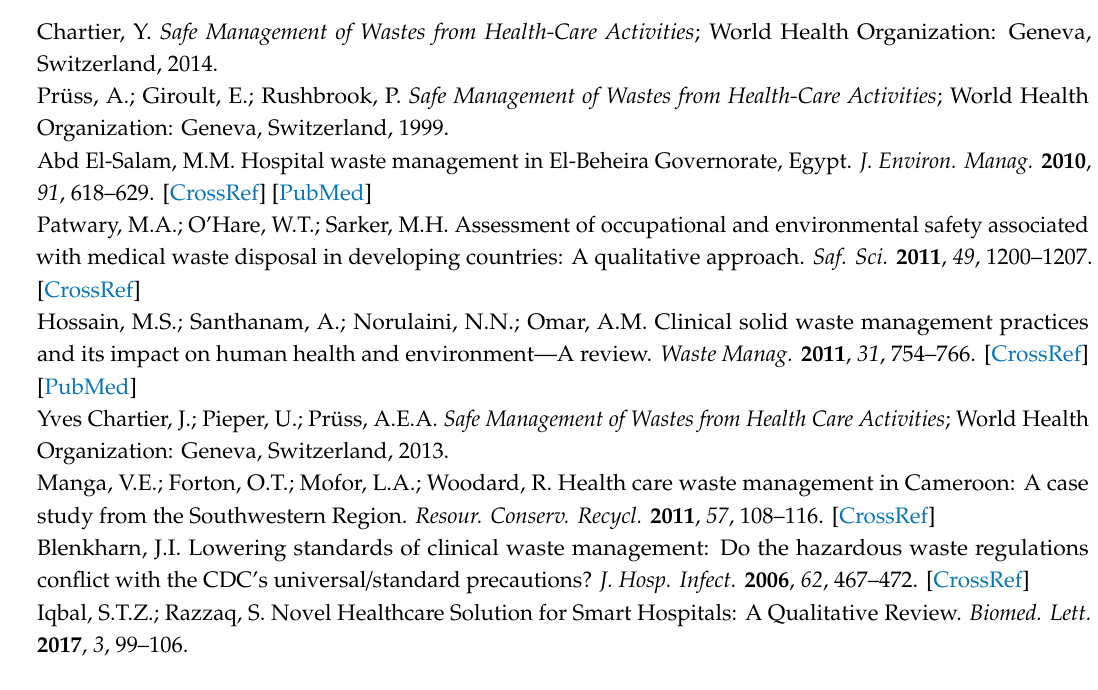
Table S1: questionnaire to assess knowledge about clinical waste management among small clinic sta ff , Table S2: questionnaire for assessing motivation for the adoption of sound healthcare waste management practices in